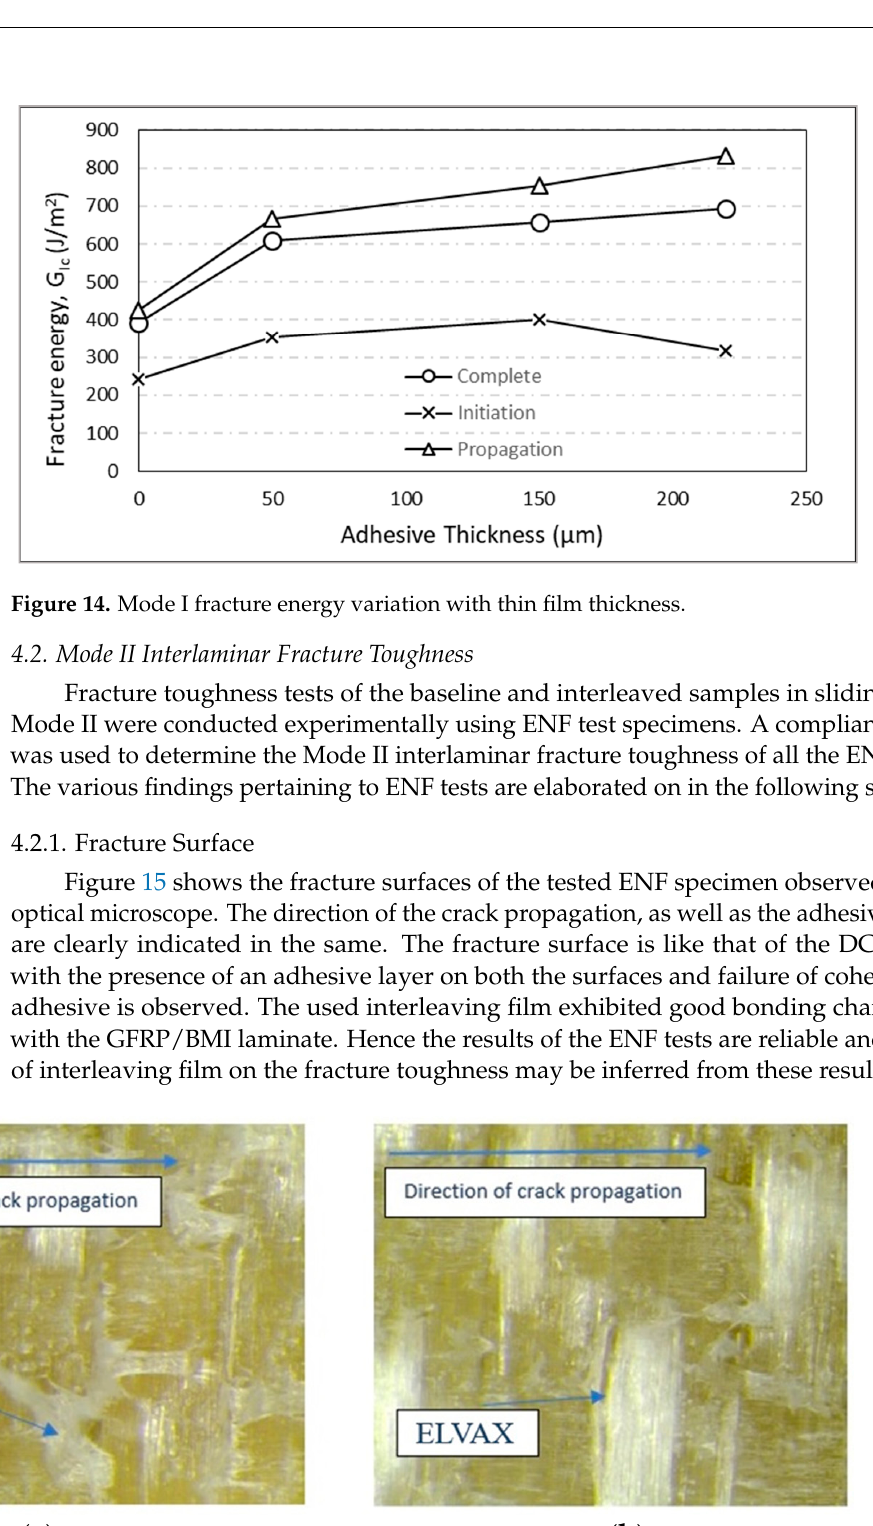
11 of 20 Figure 13. Variation of fracture energy with interleaving film thickness in Mode I. Table 3. Effect of interleaving film thickness on the fracture energy in Mode I. Adhesive Thickness ( μ m)